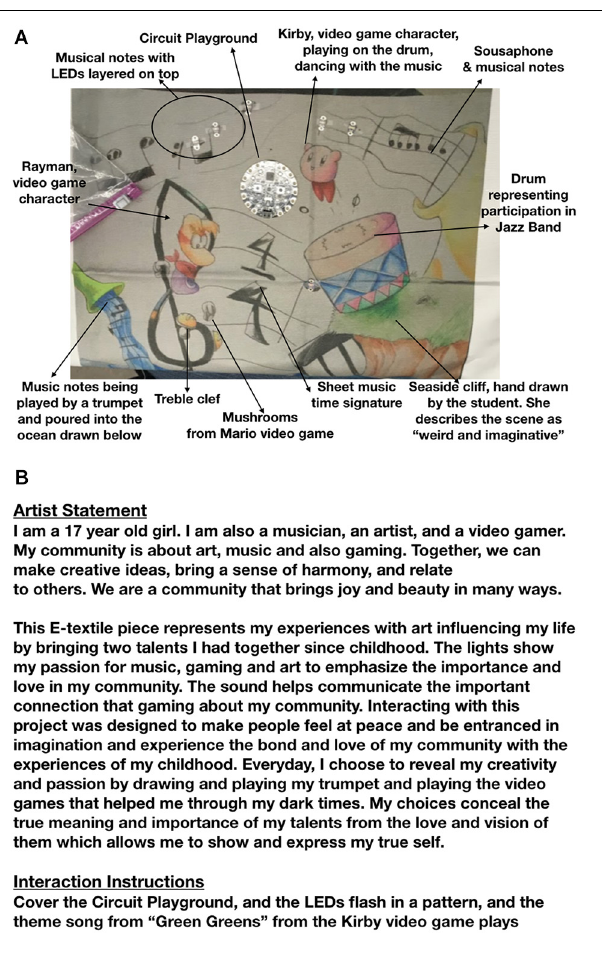
FIGURE 3 | Zoila’s Conceal/Reveal Project, Artist Statement, and Interaction Instructions.